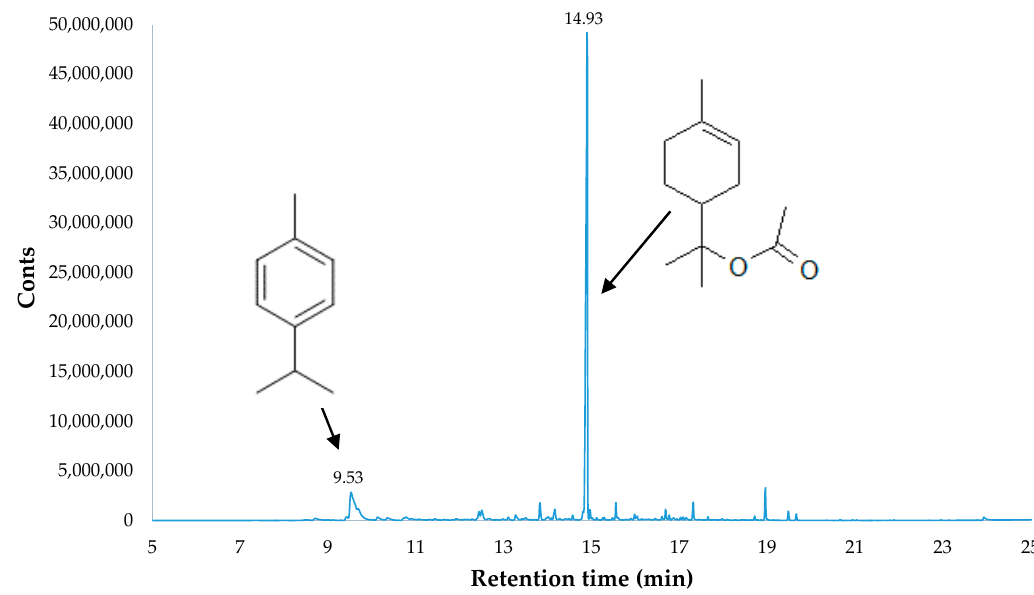
Figure 5. Chromatograms SPME–GC for the volatile fraction of dry material from Levisticum officinale. Table 2. Effect of the applied fertiliser on the chemical composition of headspace fractions of dry leaves of Coriandrum sativum L. and Levisticum officinale.